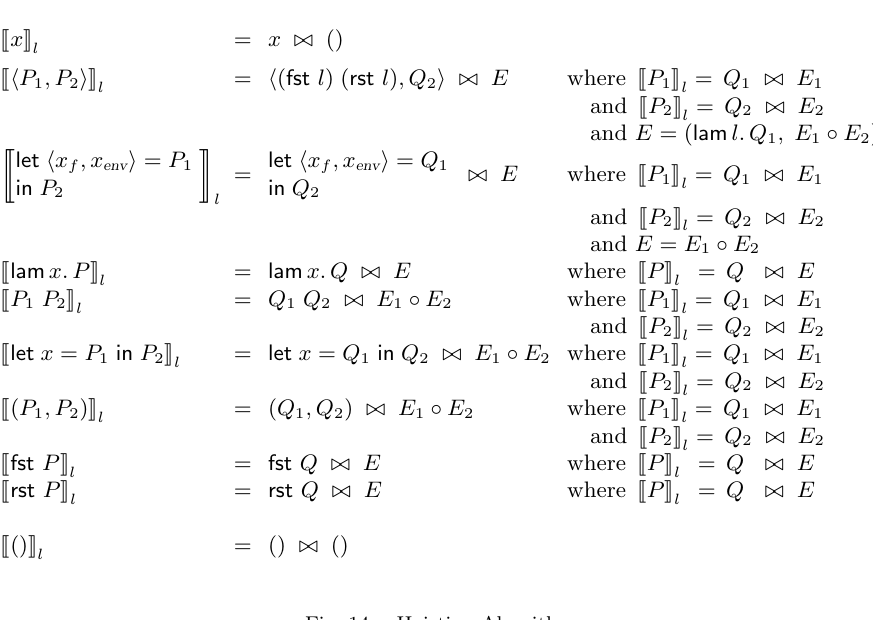
Fig. 14. Hoisting